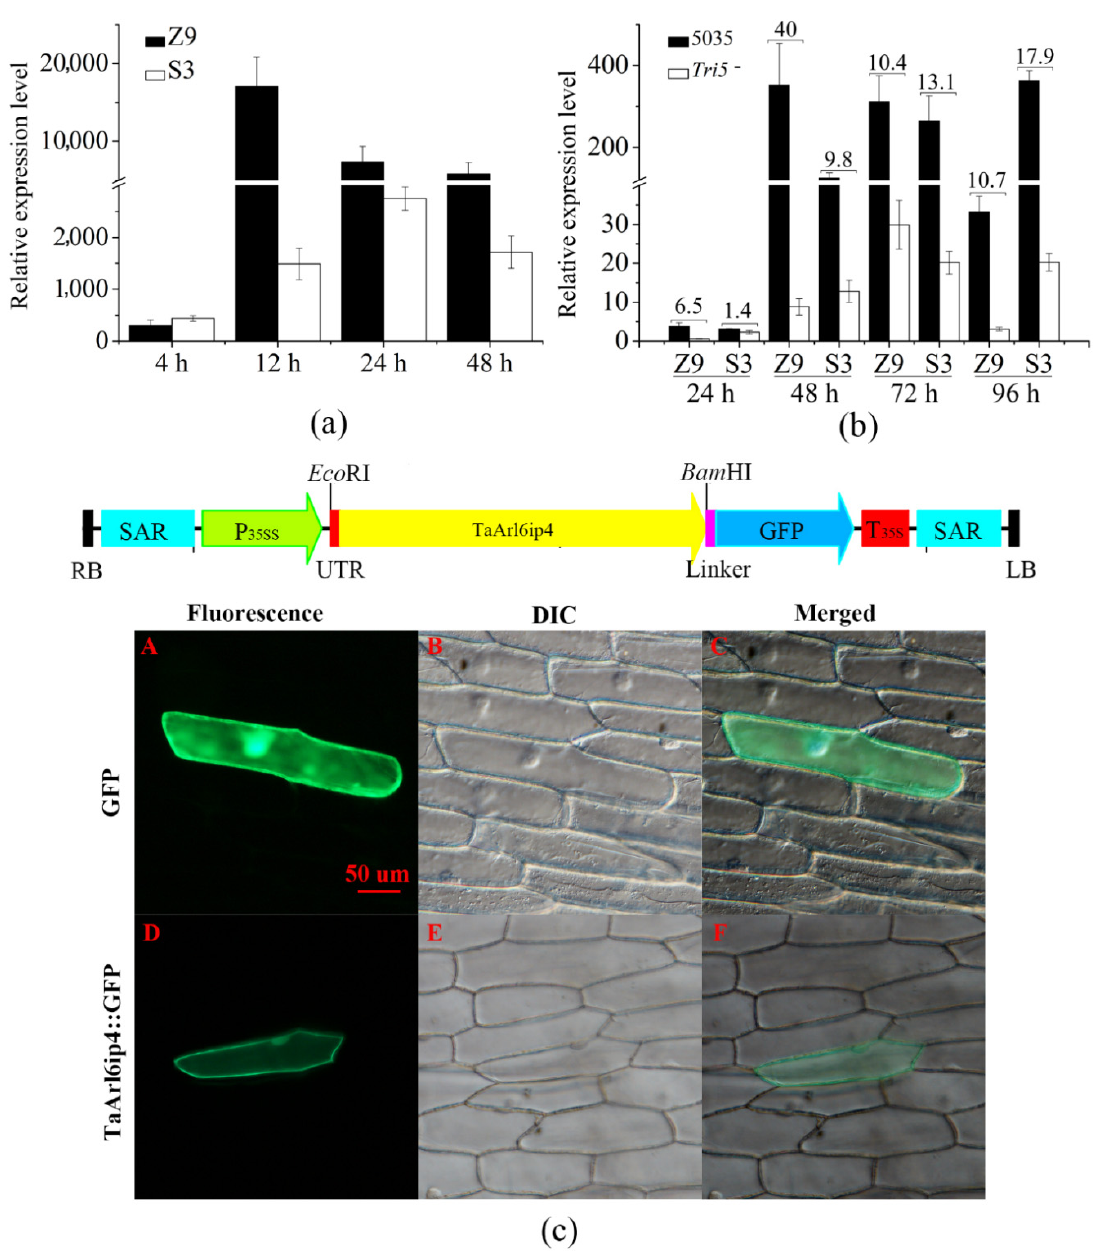
Figure 1. Expression analysis of the DON-responsive wheat gene TaArl6ip4 in planta. ( a ) Relative expression level analysis of TaArl6ip4 in Z9 and S3 wheat spikes at 4, 12, 24, and 48 hpi with DON. Z9 represents the wheat cultivar Zhengmai9023, and S3 represents the wheat cultivar Sumai3. ( b ) Relative expression level analyses of the TaArl6ip4 gene in spikes of two wheat cultivars, Z9 and S3, at 24, 48, 72, and 96 hpi after inoculation with the DON-producing strain F. graminearum 5035 (5035) or DON-nonproducing Tri5 knockout mutant strain ( Tri5¯ ). ( c ) Subcellular localization of TaArl6ip4 in onion epidermal cells. A, GFP fluorescence was detected in plasma membrane, nucleus and cytoplasm of onion epidermal cells expressing GFP alone (control). The differential interference contrast (DIC) and merged images of A are shown in B and C, respectively. D, green fluorescence of TaARL6IP4::GFP fusion construct was observed in the cell membrane and nucleus of onion epidermal cells. DIC and merged images of D are shown in E and F, respectively. The wheat β -actin gene was used as a reference gene to calculate the relative gene expression levels of TaArl6ip4 . All relative gene expression level values are the means ± standard deviations of 20 replicates.